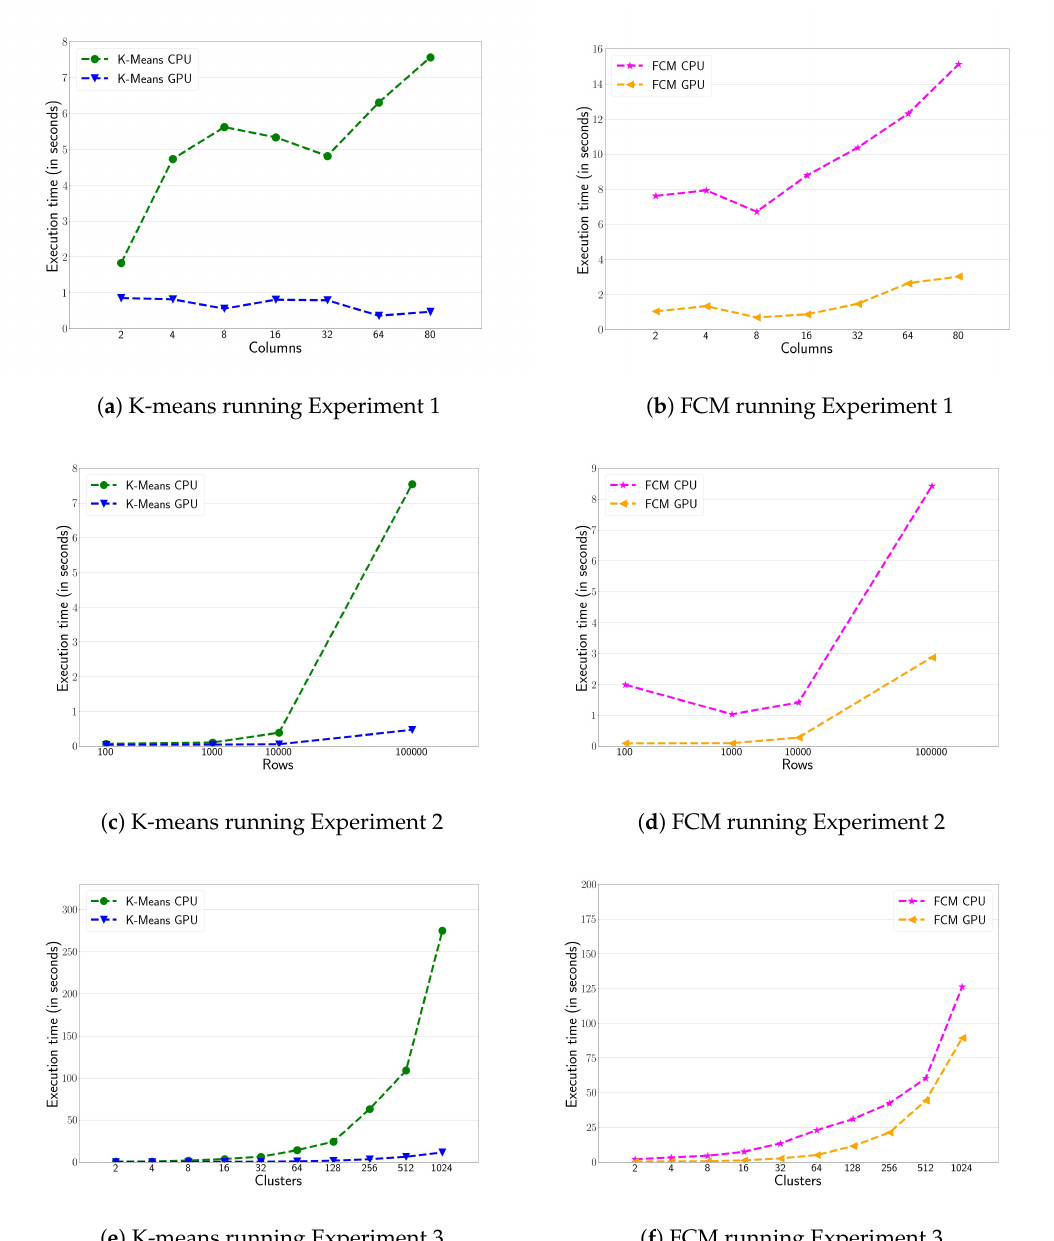
Figure 2. Execution time (in seconds) of the clustering of the k-means (right-hand side) and Fuzzy C-Means (FCM) (left-hand side) algorithms for the three experiments described in Section 4.1. GPU and CPU versions are executed in the HPC